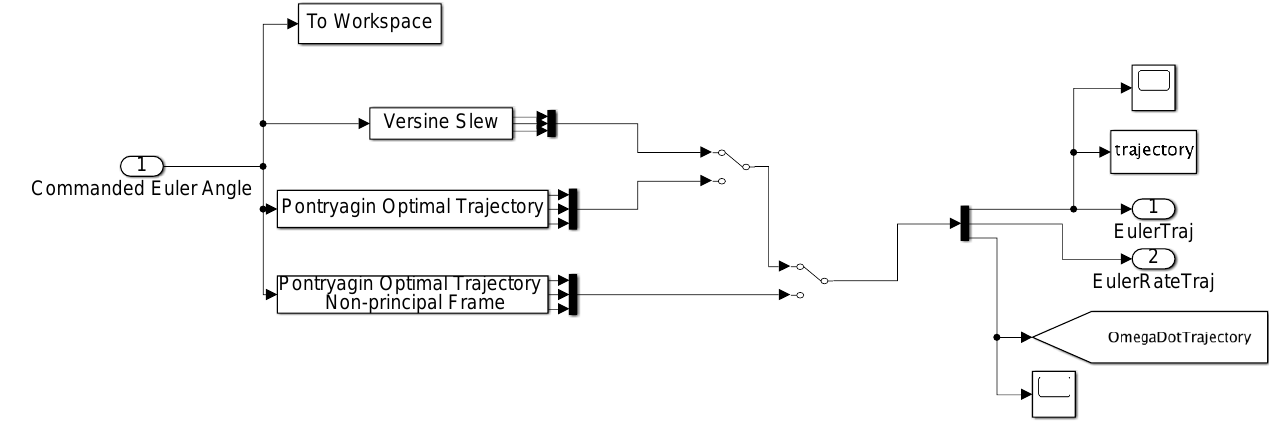
Figure A2. Trajectory generation block model.